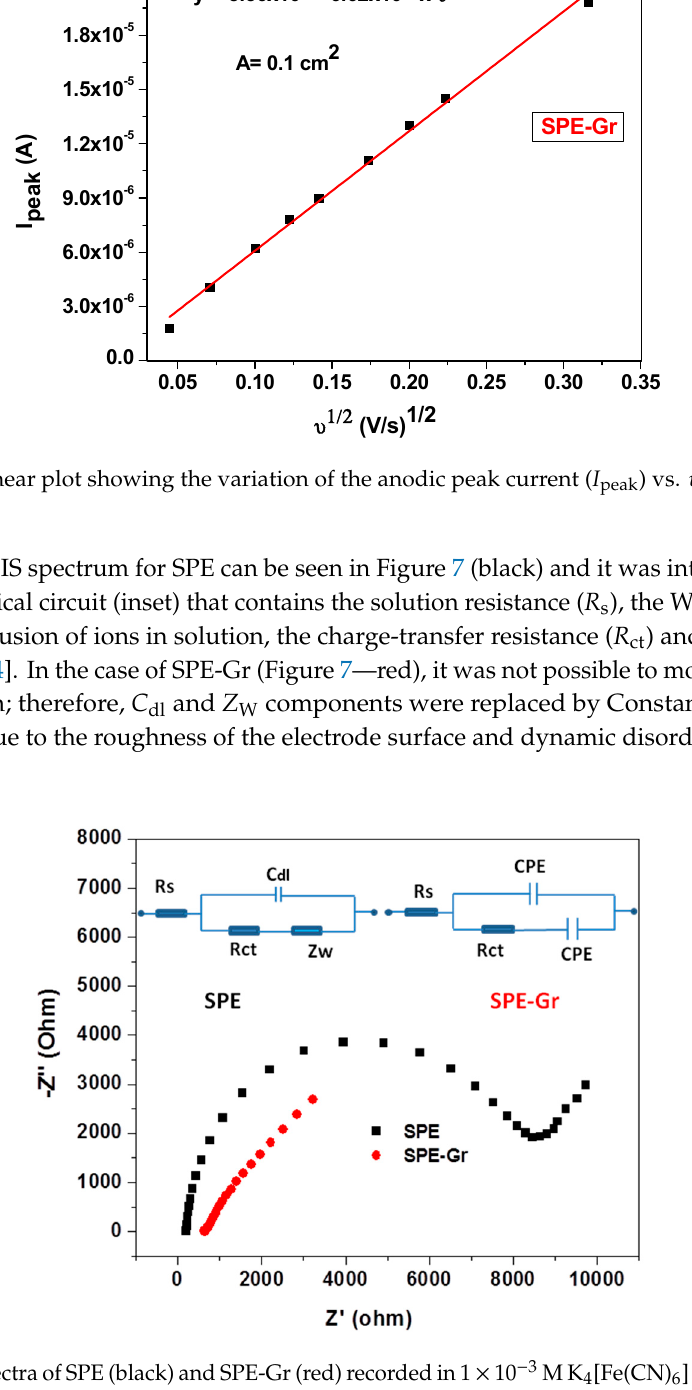
Figure 6. The linear plot showing the variation of the anodic peak current ( I peak ) vs. ʋ 1/2 for ( a ) SPE and ( b ) SPE-Gr.